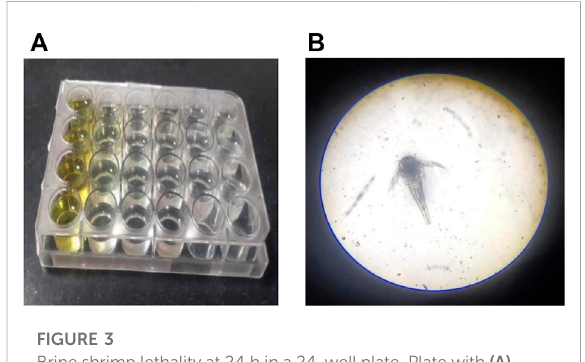
FIGURE 3 Brine shrimp lethality at 24 h in a 24-well plate. Plate with (A) sample and (B) brine shrimp.